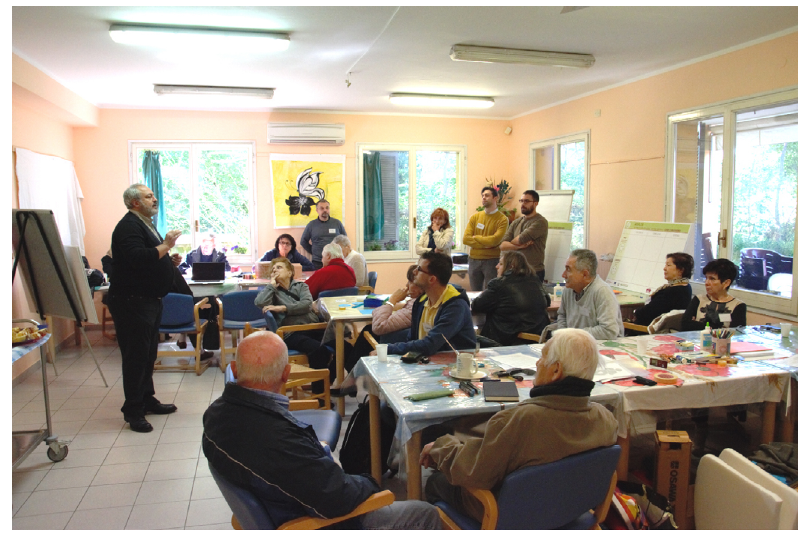
First workshop setting. Source: GA. Giacobone,